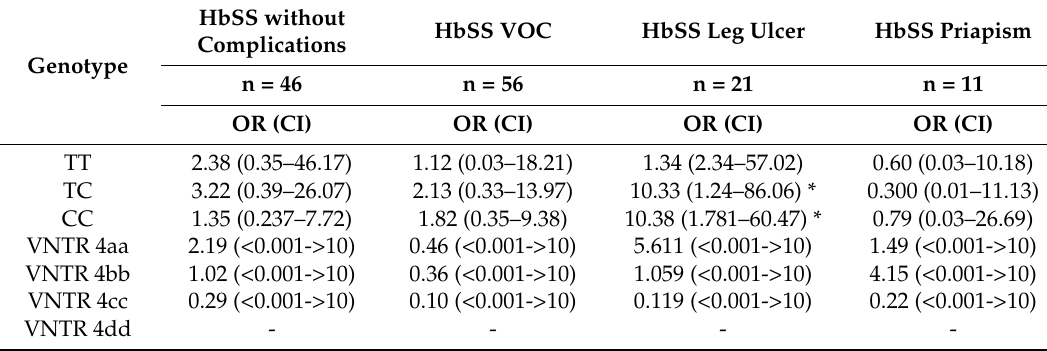
Table 3. Association of eNOS gene variants in the studied